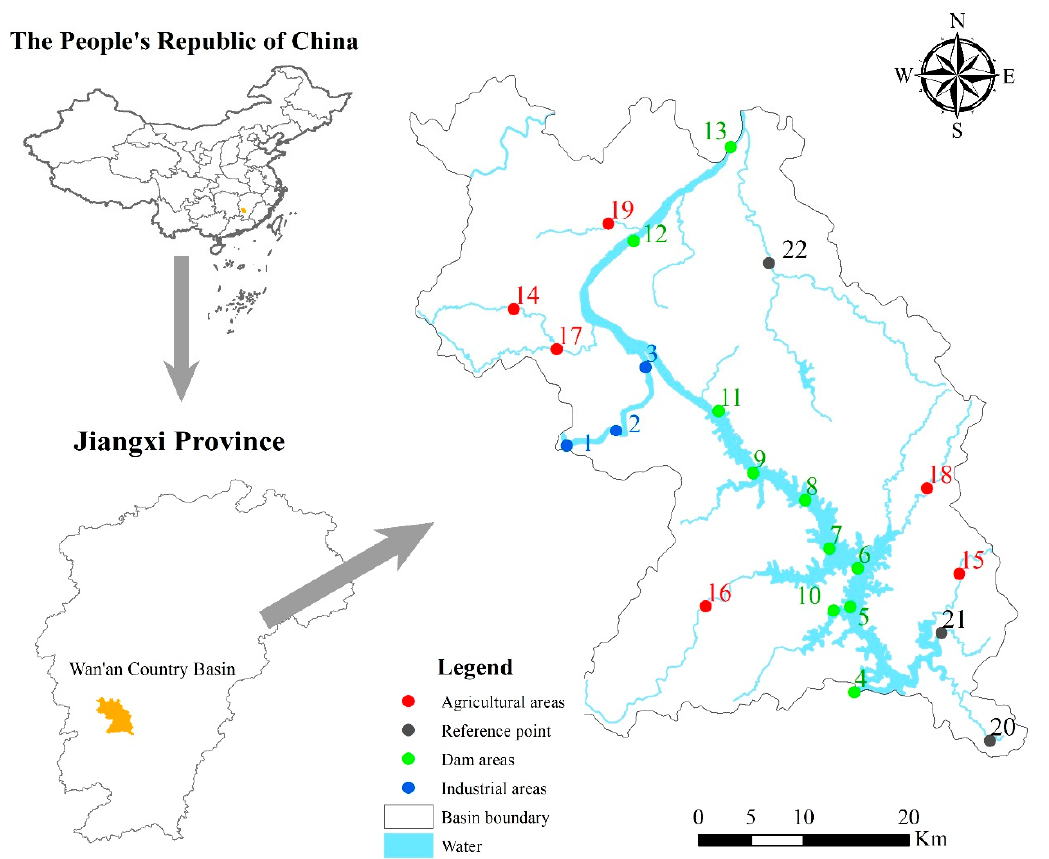
Figure 1. Sampling locations in the Wanan River basin, China.